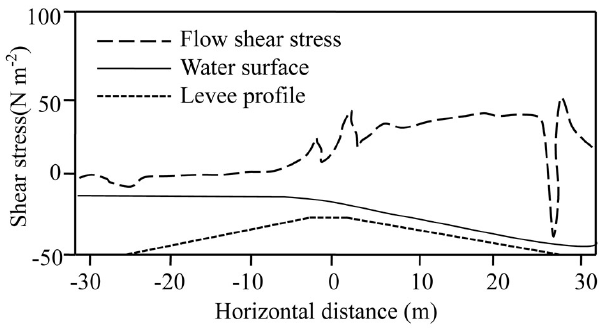
Figure 4. A typical flow shear stress distribution along the dike cal- culated by Briaud et al.